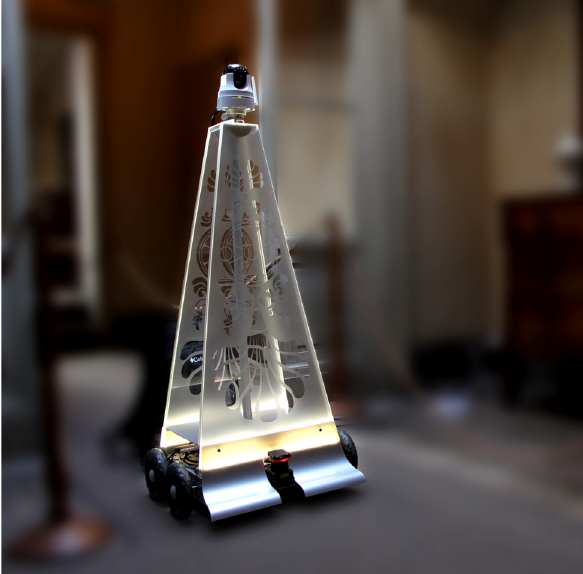
Figure 5 | The Virgil